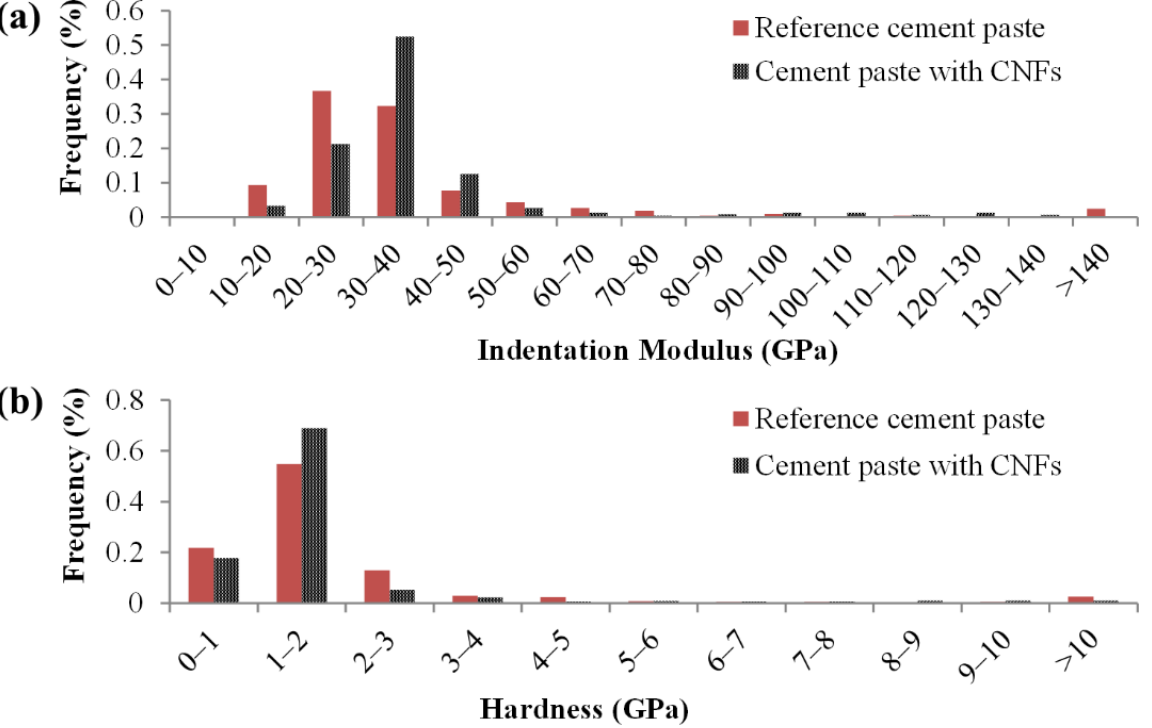
Figure 3. Histograms of the indentation ( a ) modulus and ( b ) hardness for the reference cement paste (414 valid indents) and the cement paste with CNFs (479 valid